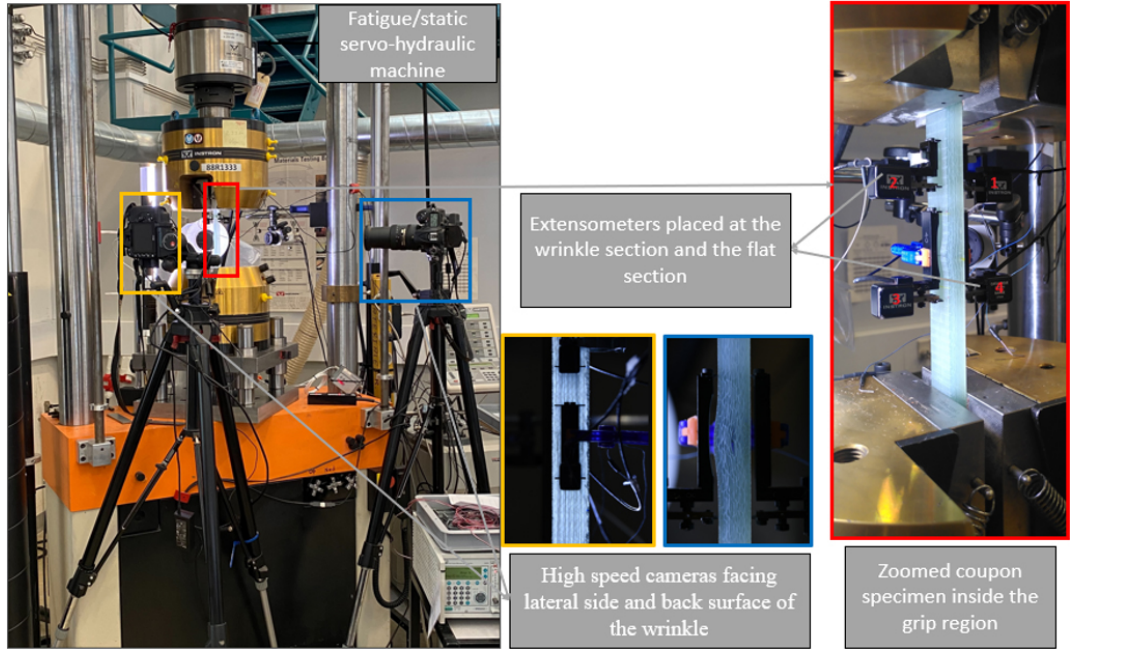
Figure 8. Experimental setup with the specification of devices used for test and acquisition of results, with the positioning of coupon specimen in the test rig and placement of acquisition channels around the gauge section.